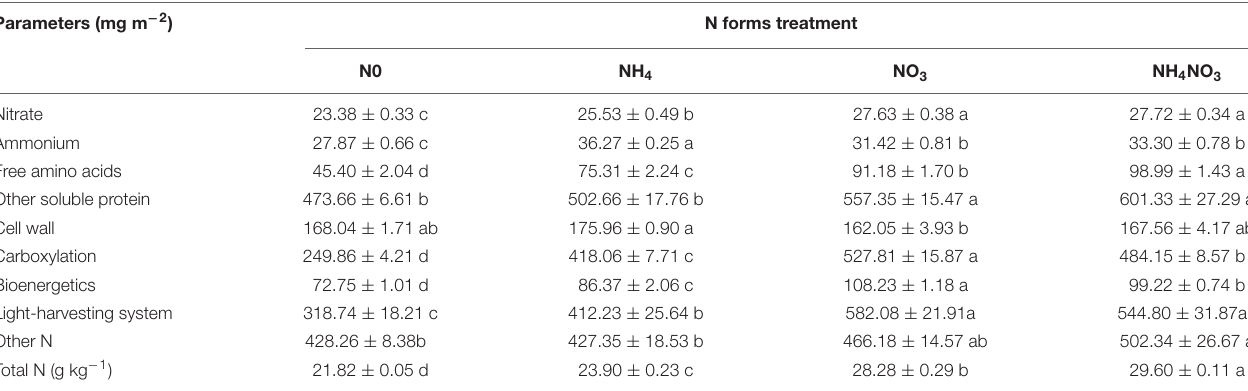
TABLE 1 | Effect of nitrotgen (N) forms treatments on the content of N compounds in L. chinensis . Parameters (mg m − 2